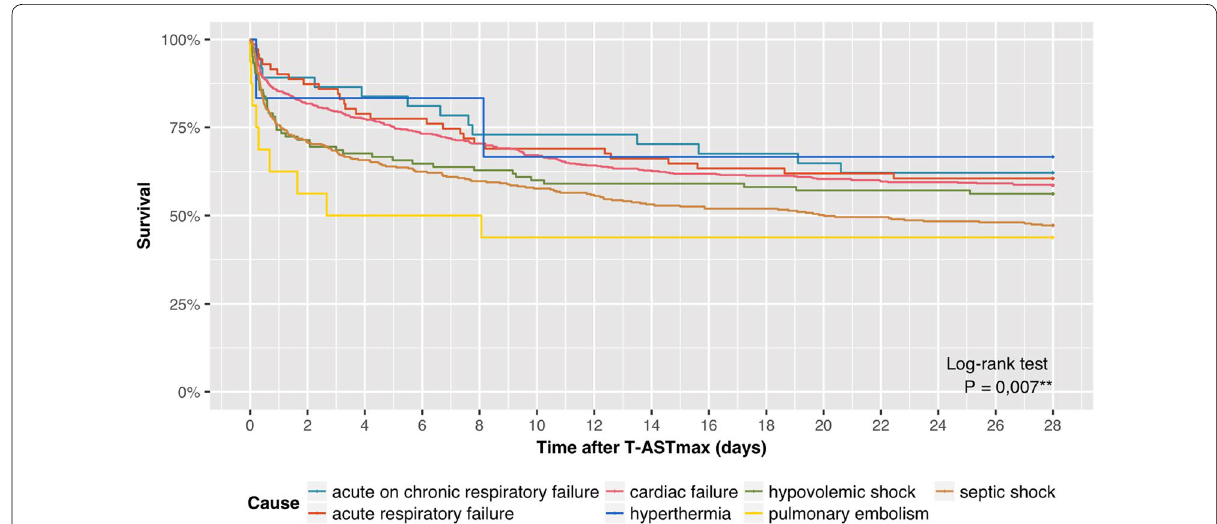
Fig. 2 Survival curves by cause of hypoxic hepatitis. T-ASTmax is designated as the time 0. T-ASTmax time point of maximum AST